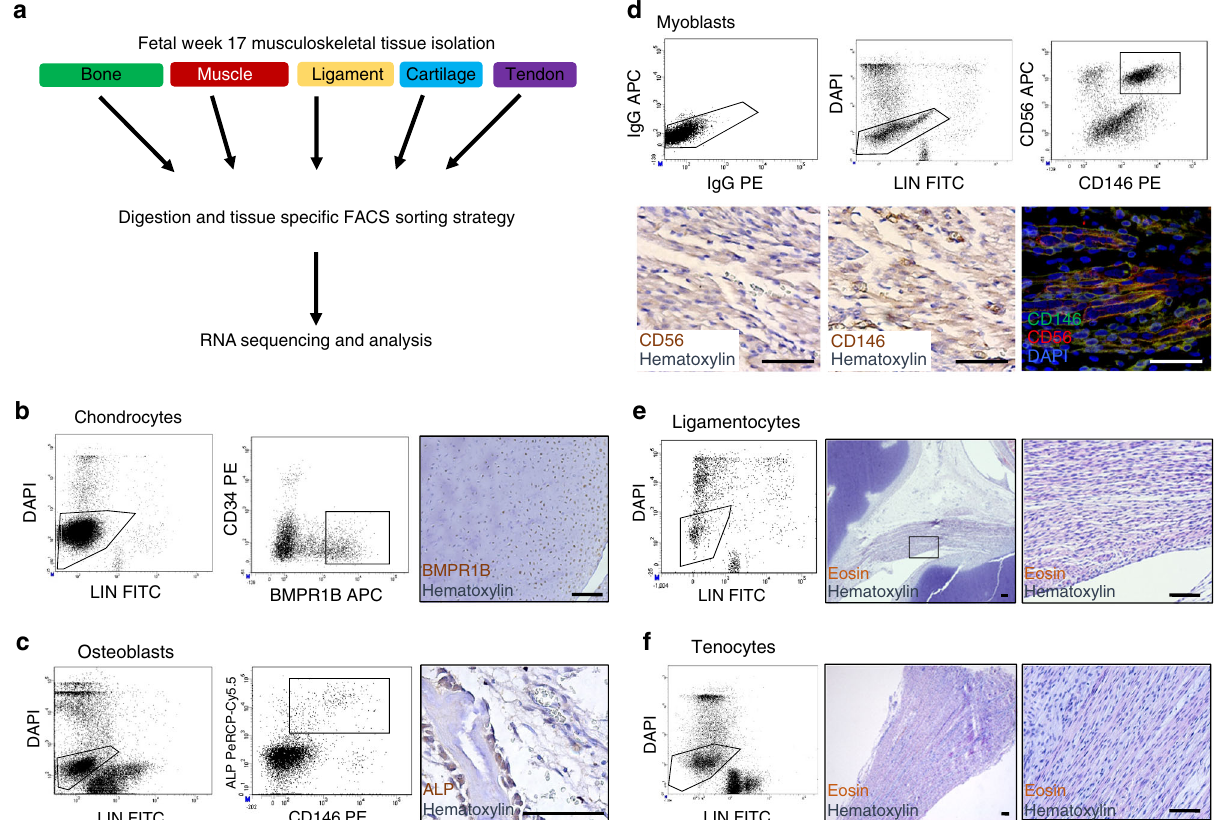
Fig. 1 Identi fi cation and puri fi cation of fi ve human fetal musculoskeletal lineages. a Strategy for assessing lineage diversi fi cation during human development. For all populations, cells were isolated as lineage (LIN) negative (CD235a − CD45 − CD31 − ). b Chondrocytes were sorted as LIN − CD34 − BMPR1B + cells. BMPR1B positively labels the super fi cial zone of fetal articular cartilage. c Osteoblasts were sorted as LIN − ALP + cells. ALP (alkaline phosphatase) positively labels endochondral osteoblasts in fetal trabecular bone. d Myoblasts were isolated based on LIN − CD56 + CD146 + expression. Co- expression of CD56 (red) and CD146 (green) in fetal myoblasts was con fi rmed by immuno fl uorescence. e Ligamentocytes and f tenocytes were depleted of LIN + cells following digestion of anterior/posterior cruciate ligament and Achilles tendons, respectively. N = 3 – 4; scale bars = 50 µ